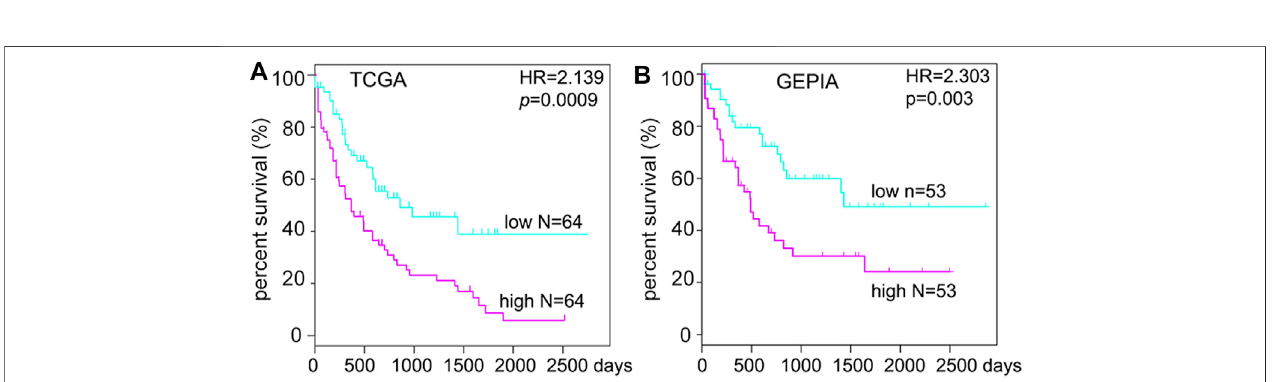
FIGURE 2 | SMPDL3B mRNA expression levels negatively correlate with the overall survival of human AML patients. Kaplan – Meier analysis of overall survival in AML patients relative to SMPDL3B mRNA expression levels. (High: above the 50th percentile; low: below the 50th percentile.) Data were obtained from the TCGA AML database (A) and GEPIA (B), respectively. p value was calculated by the log-rank